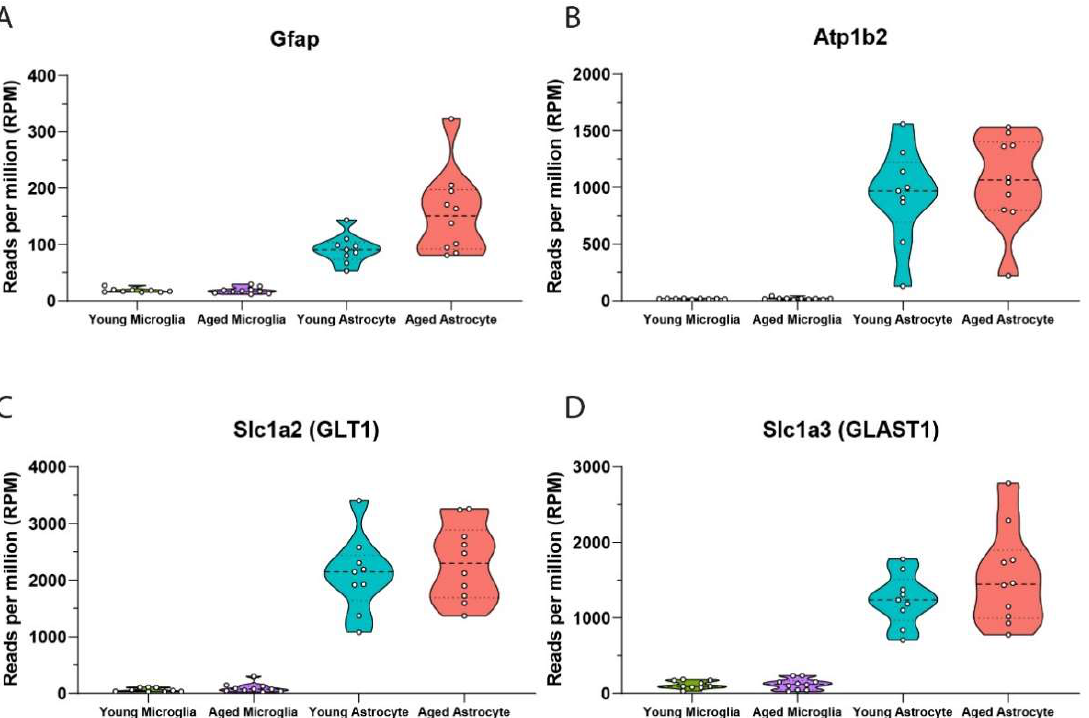
Figure 10. Transcriptomic validation of sequentially isolated astrocytes from adult mouse brain. mRNA analysis shows astrocytes that are isolated after microglial preparations have high expression of astrocyte specific markers ( A ) Gfap, ( B ) Atp1b2, ( C ) Slc1a2 and ( D ) Slc1a3 (young microglia n = 9, young astrocyte n = 9, aged microglia n = 10, aged astrocyte n = 10). Data from 3 independent experiments run on different days, a total of n = 3/day for young mice and n = 3, 3, 4 per day for aged mice.